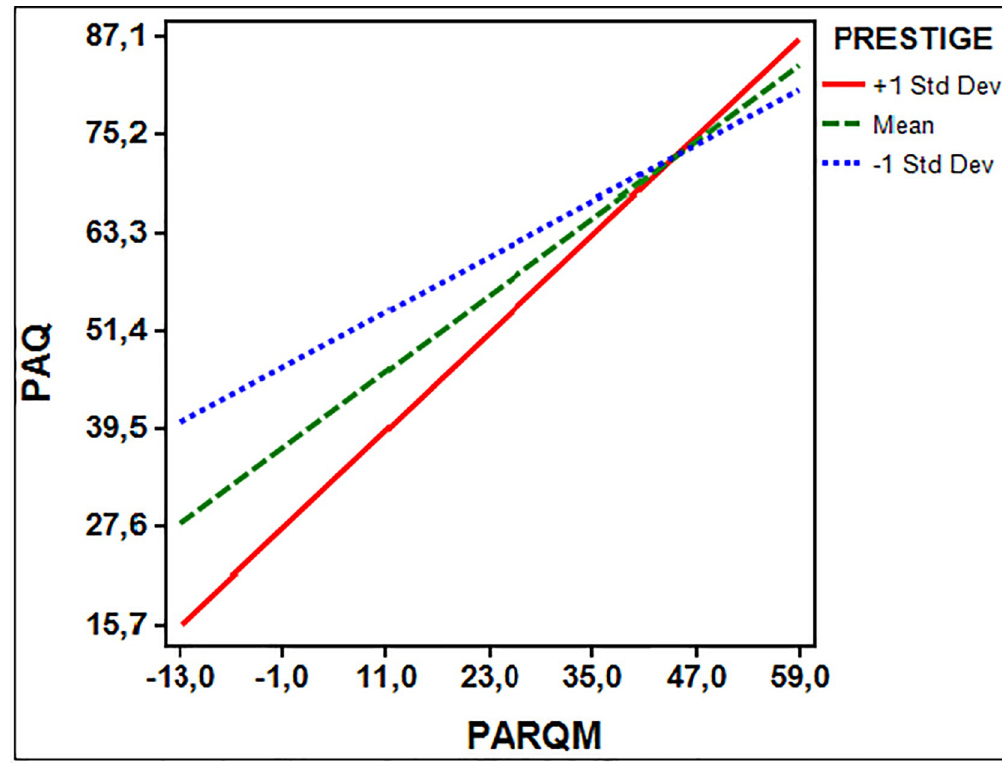
Fig 2. Maternal acceptance-rejection predicting psychological maladjustment at varying levels of prestige in early adolescence (11–12 years old). PAQ = psychological maladjustment (higher scores are indicating maladjustment); PARQM (higher scores are indicating maternal